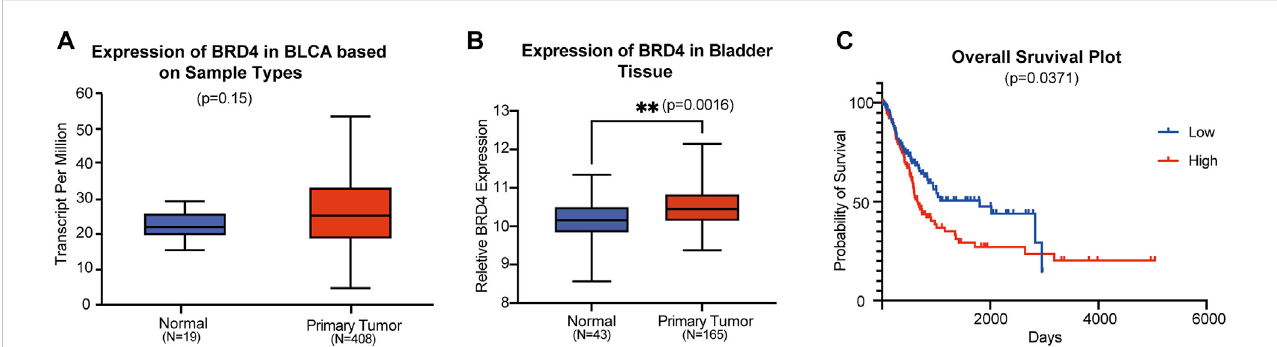
FIGURE 1 Association of BRD4 expression and bladder cancer risk (A) The BRD4 mRNA expression level of bladder tissues were analyzed in TGCA cohorts. The p -value was examined by Mann – Whitney U-test. (B) The relative expression level of BRD4 was determined in GEO database (GSE48276 and GSE13507). The removeBatchEffectfunctioninthelimmapackagewasusedtoremovebatches.The p -valuewasexaminedbyWelch ’ s t -test. (C) TheriskofBRD4expression for survival analysis in 240 well-de fi ned BC cases derived from TCGA databases was performed by the Kaplan-Meier plotter online. The p -value was calculated by a log-rank